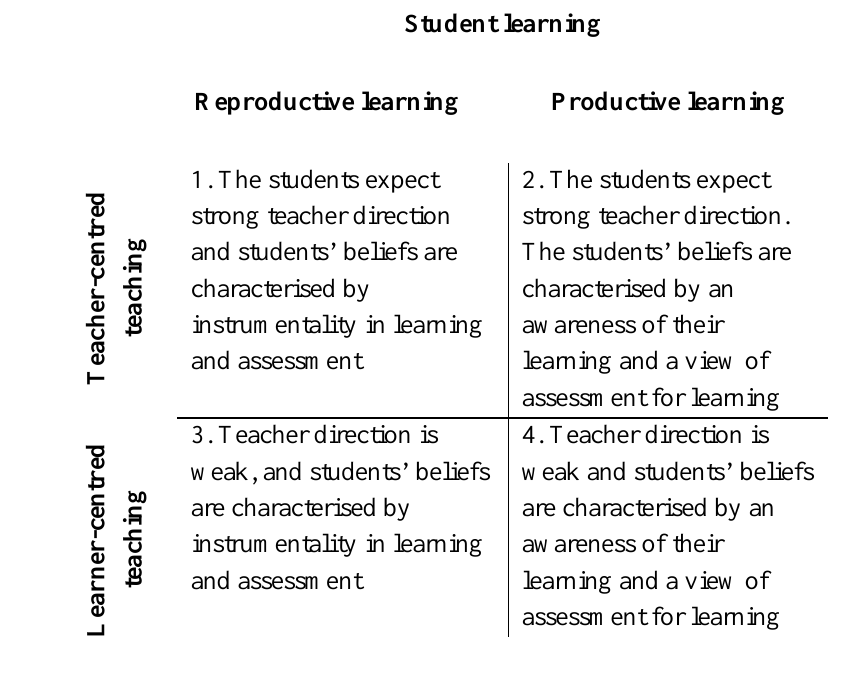
The Student-Teacher Relationship in Process-Based